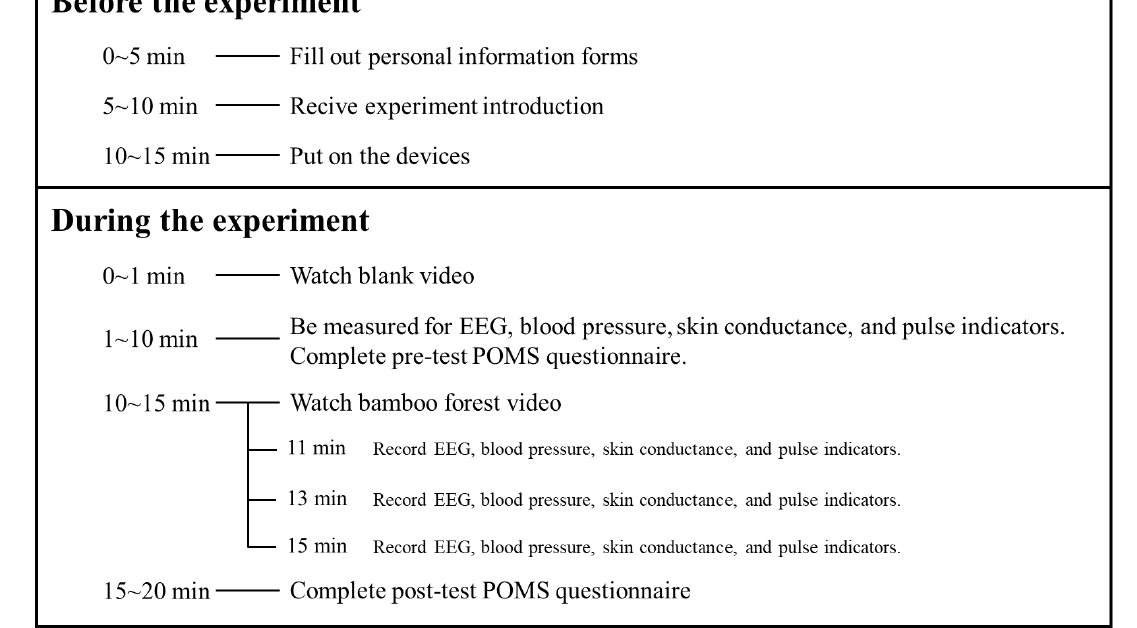
Figure 3. Experimental schedule for each participant. POMS, Profile of Mood States.